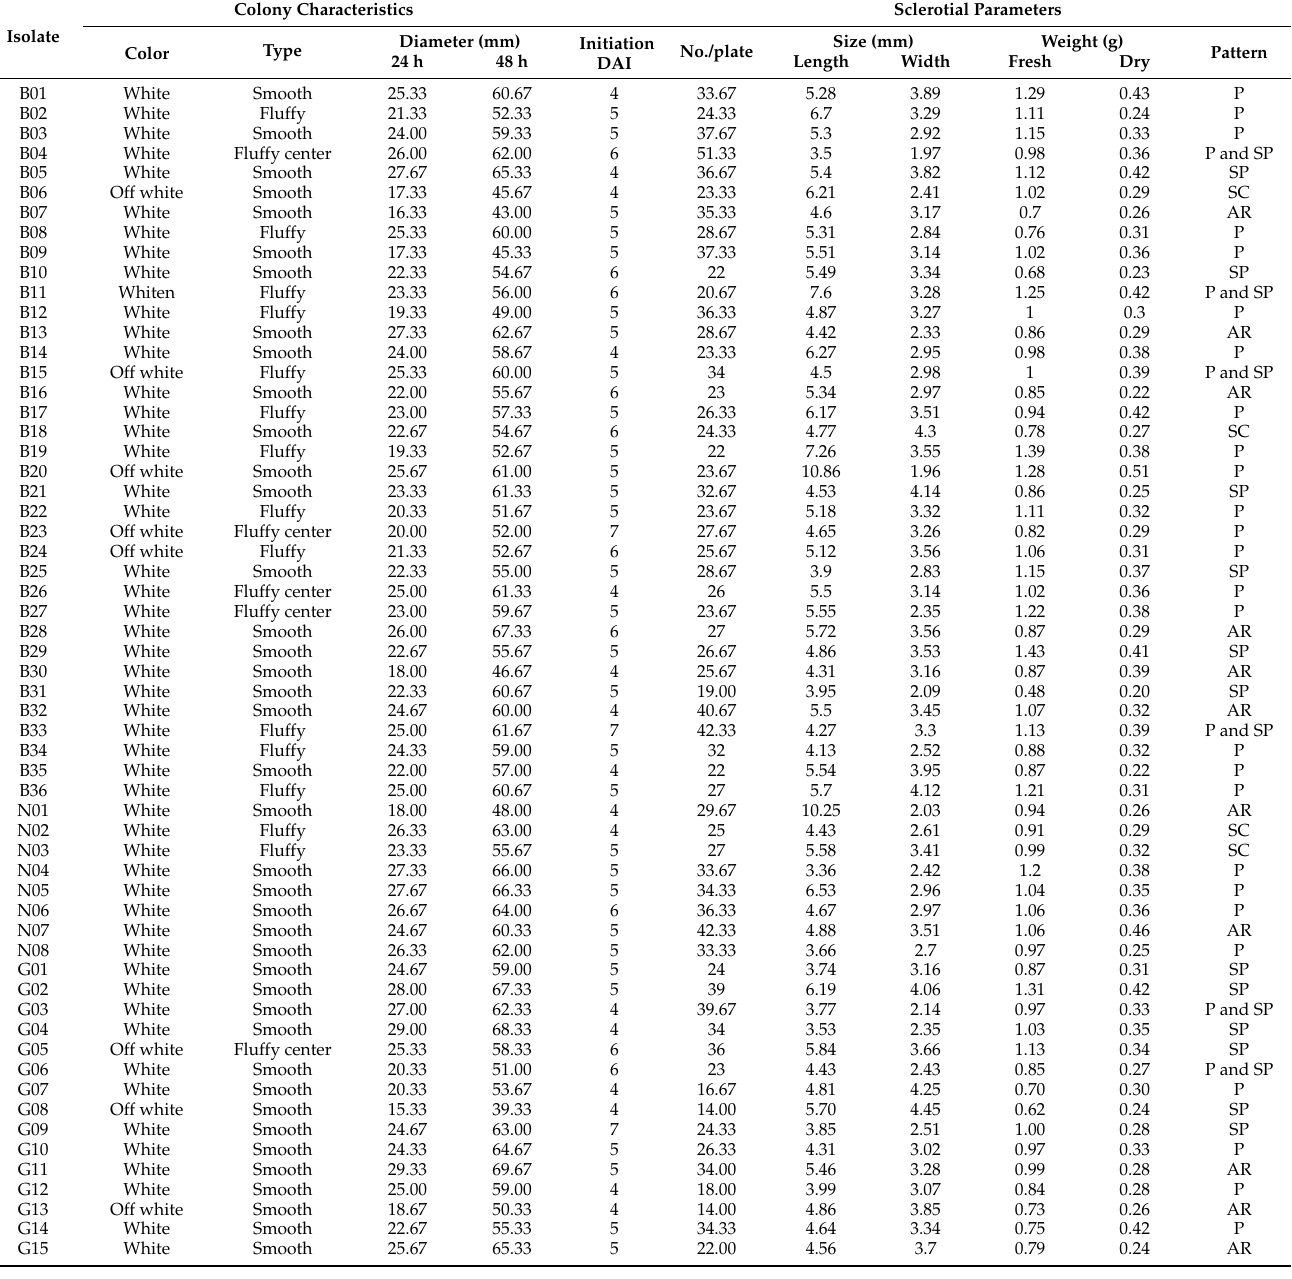
Table 4. Morpho-cultural characteristics of 80 isolates of S. sclerotiorum isolates from bean crops collected from North